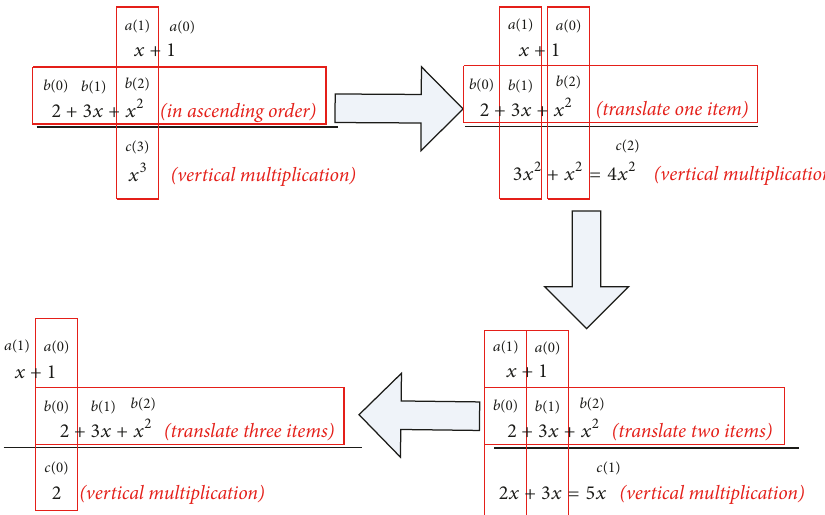
Figure 1: Relationship between convolution and polynomial weighted average.